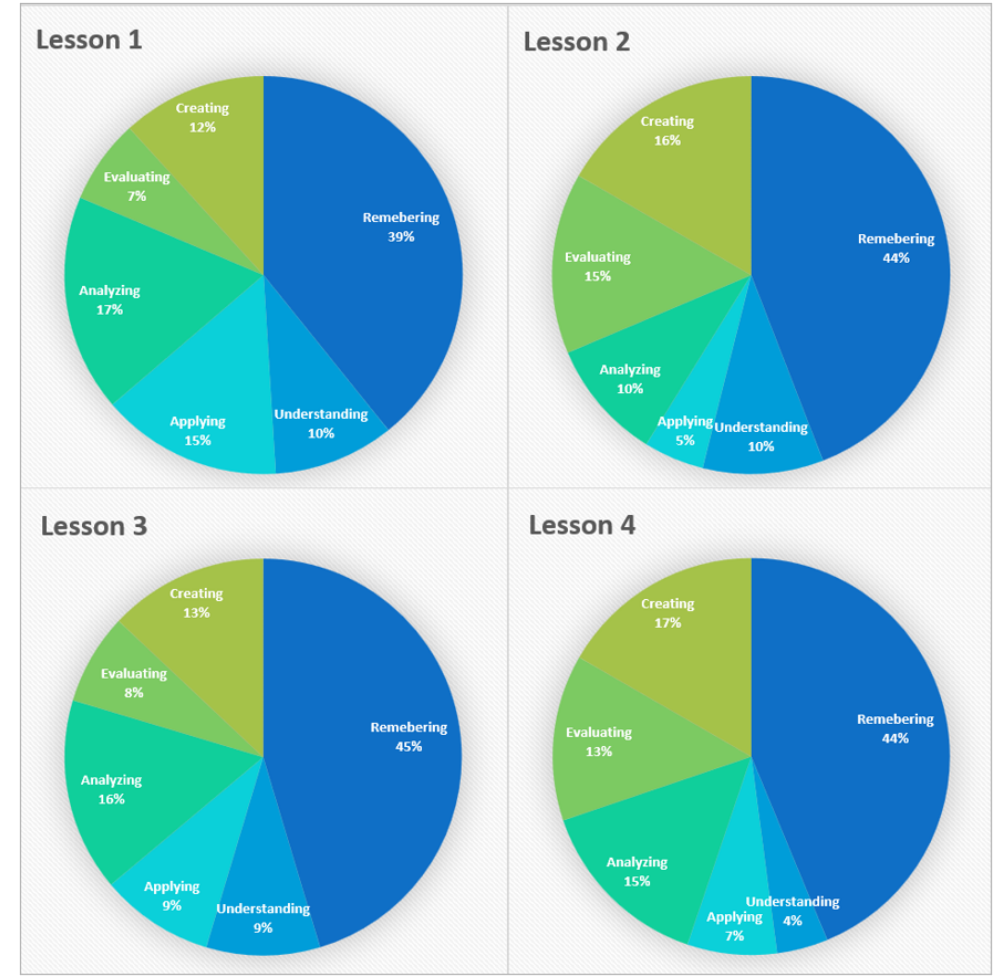
Figure 10. Frequency of Bloom’s abilities detected in each lesson. Table 5. Number of students who expressed each